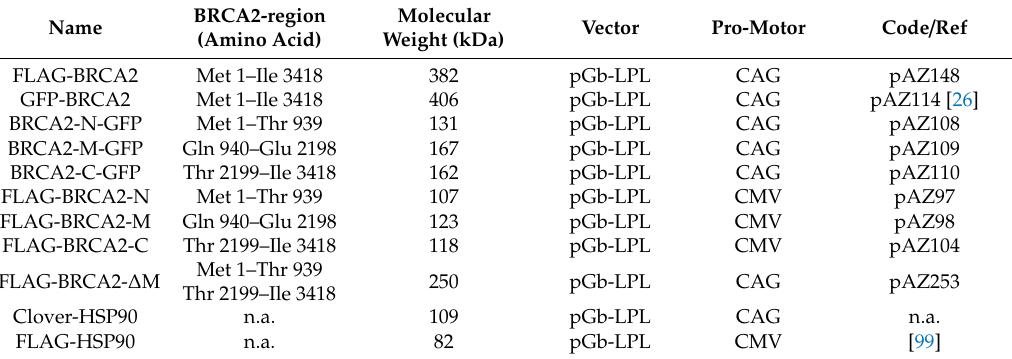
Table 2. List of constructs.